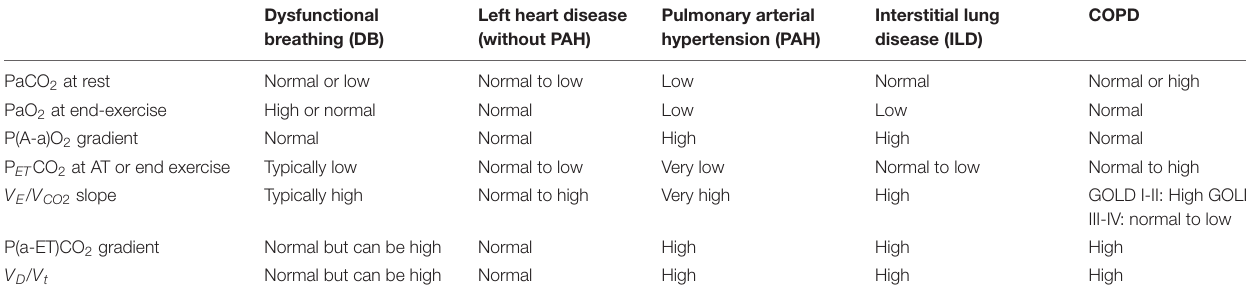
TABLE 1 | Summary of typical blood gas and CPET findings in DB compared to other diseases.